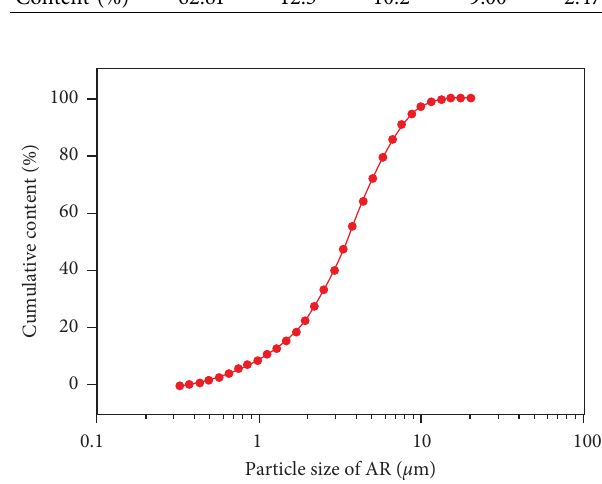
Figure 3: The curve of particle size analysis of